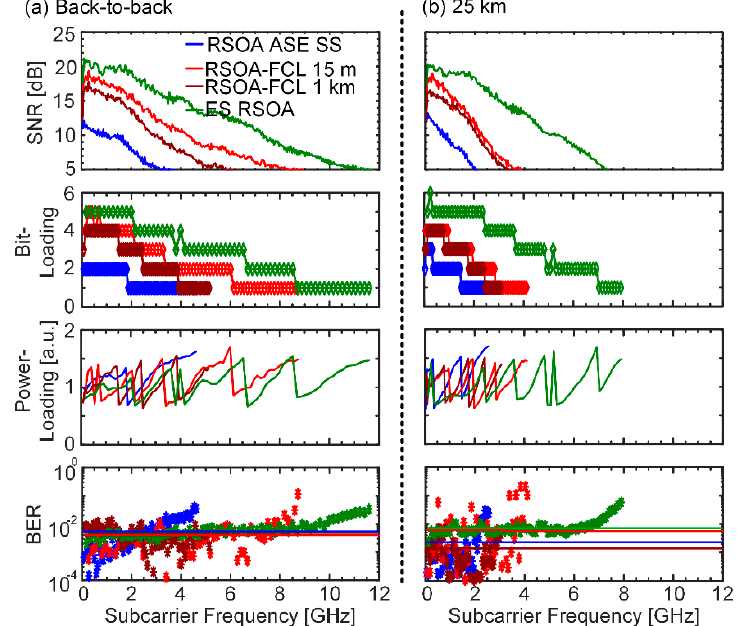
Figure 11. Measured SNR, bit- and power-loading pattern and per-subcarrier BER for the three transmitter schemes: RSOA ASE spectrum-sliced (SS) (blue), self-seeded RSOA-FCL (red and brown) and externally seeded (ES) RSOA (green). ( a ) and ( b ) show results for back to back case and 25 km transmission. The ASE spectrum sliced scheme can support modulation formats with up to 3 bits/symbol while RSOA-FCL and externally seeded RSOA can encode up to 6 bits/symbol for low subcarrier frequencies. The solid line in the bottom plot indicates the overall BER that can be achieved with either of the three transmission schemes. All bit-error ratios are within the FEC (forward error correctio) limit of 7.5 × 10 − 3 .